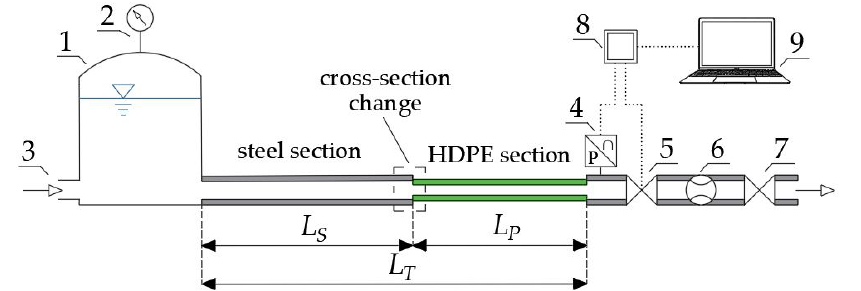
Figure 2. Laboratory setup: 1—pressure tank; 2—Bourdon pressure gauge; 3—water supply system; 4—pressure sensor; 5—valve initiating water hammer; 6—inductive flowmeter; 7—regulating valve;